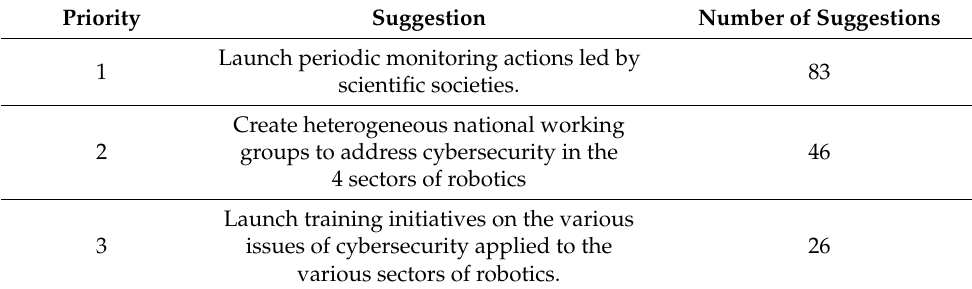
Table 14. Suggestions on the actions to consider. Priority